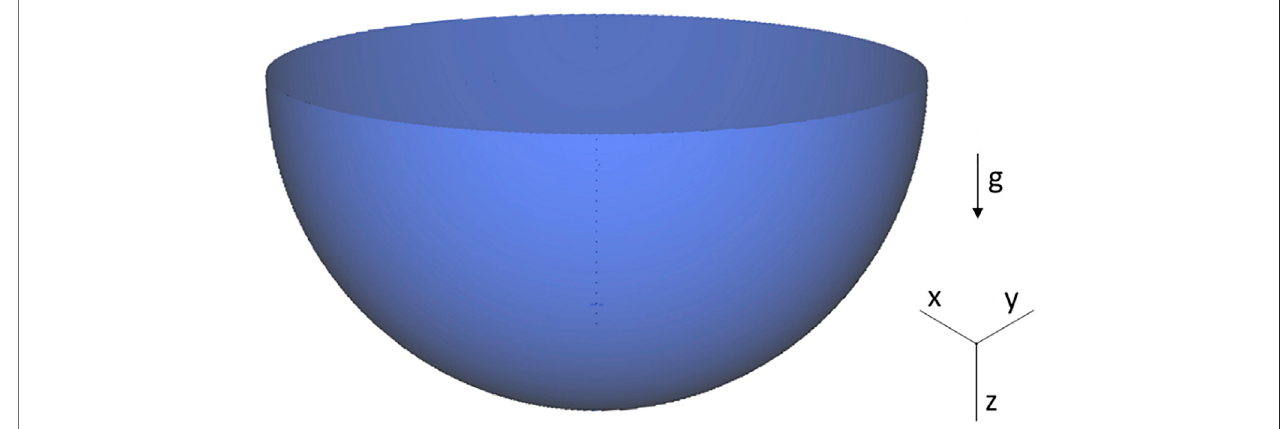
FIGURE 4 | Computational domain.